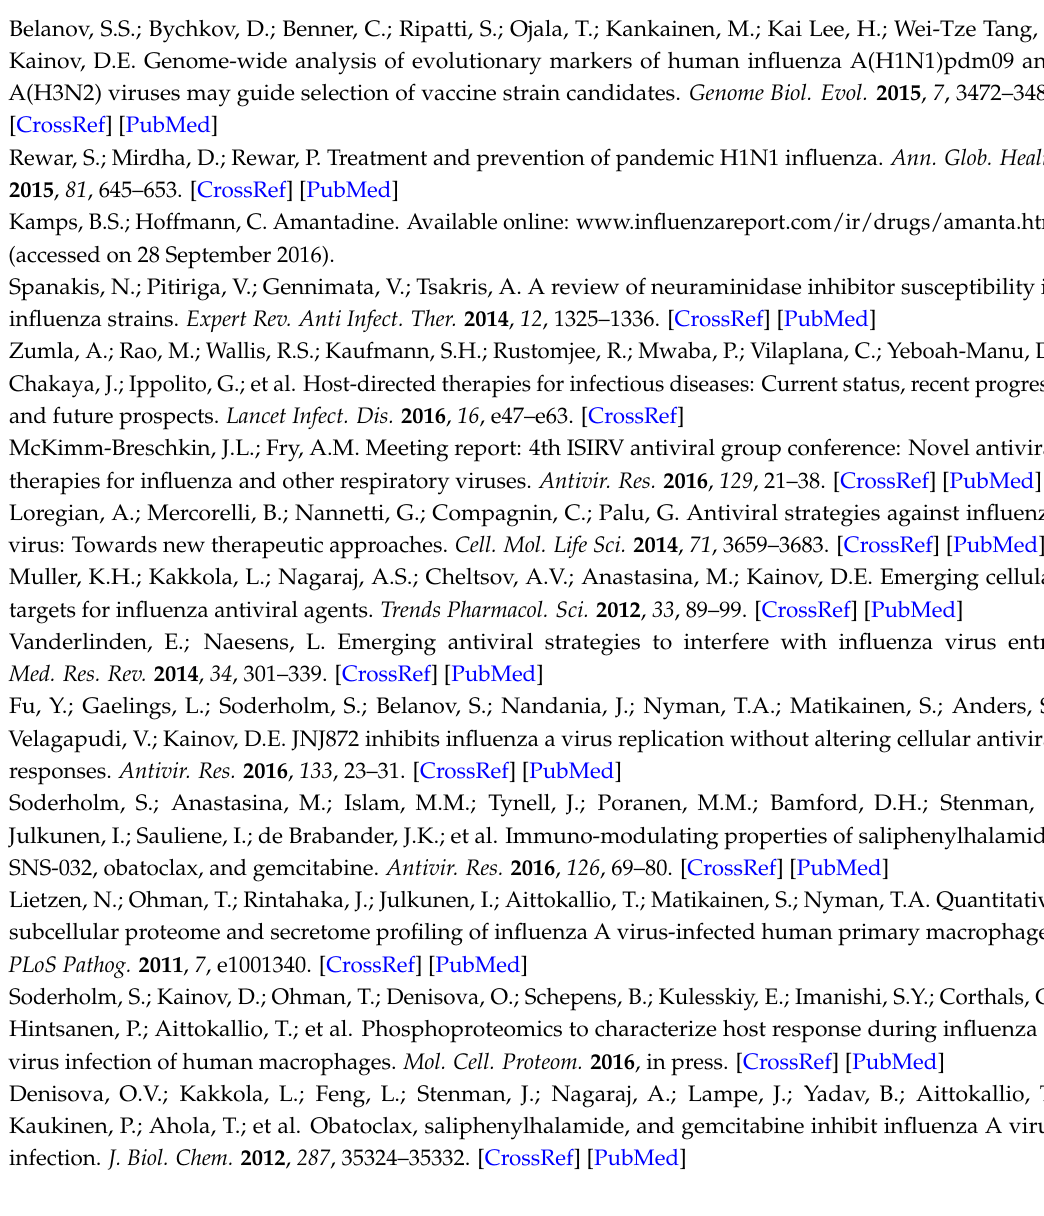
Table S1: Genes and proteins implicated in influenza A virus-host interactions and potential modulators of these interactions which were identified through our omics studies, Table S2: Druggable host factors of IAV–host interactions which were identified through our omics studies with cross references to other studies, Table S3: Compounds identified through our omics studies with cross references to other